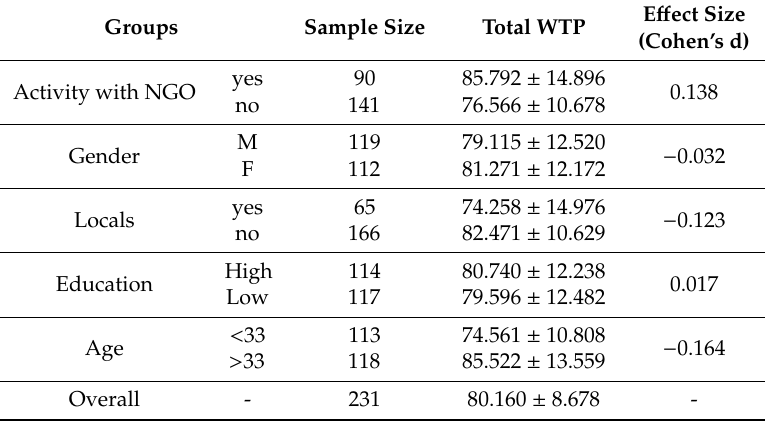
Table 4. Total WTP by groups (US$ / person / year).